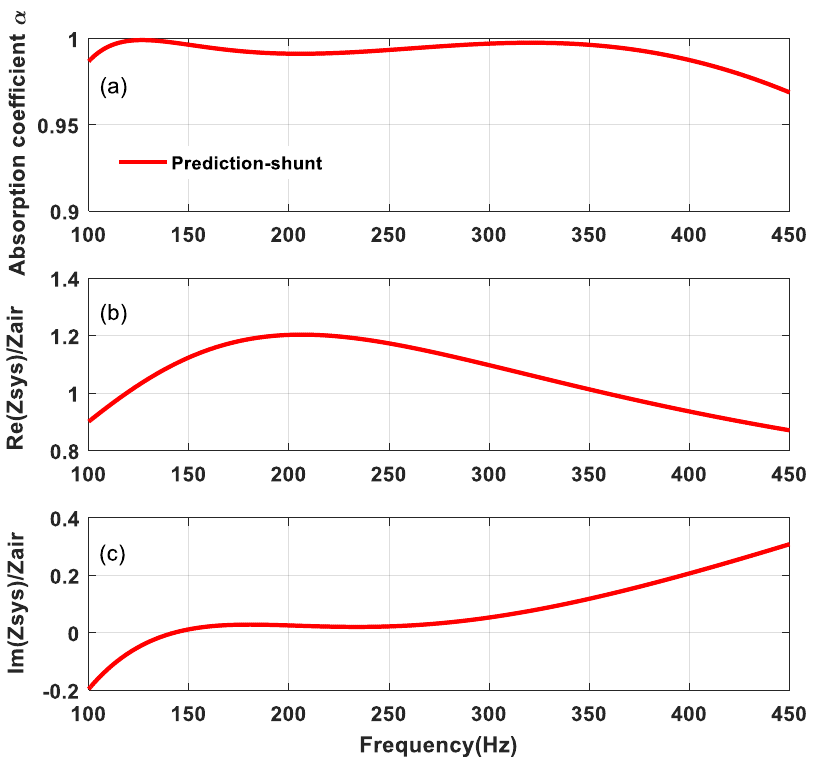
Figure 2. Optimized sound absorption of the SL by a six – dimensional EBA, ( a ) the sound absorption coefficient, ( b ) the specific acoustic resistance, ( c ) the specific acoustic reactance. Table 2. Parameter upper bounds and step size settings.